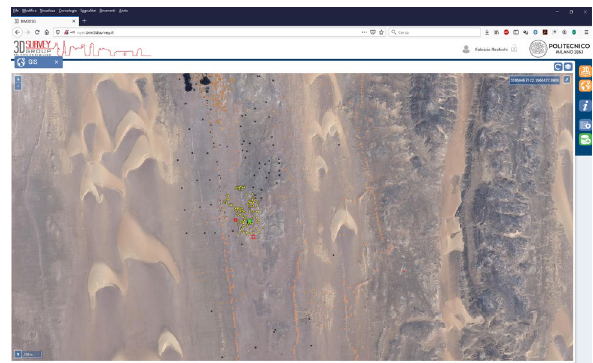
Figure 10 – The GIS component working on the Umm al- Dabadib area, with the use of satellite